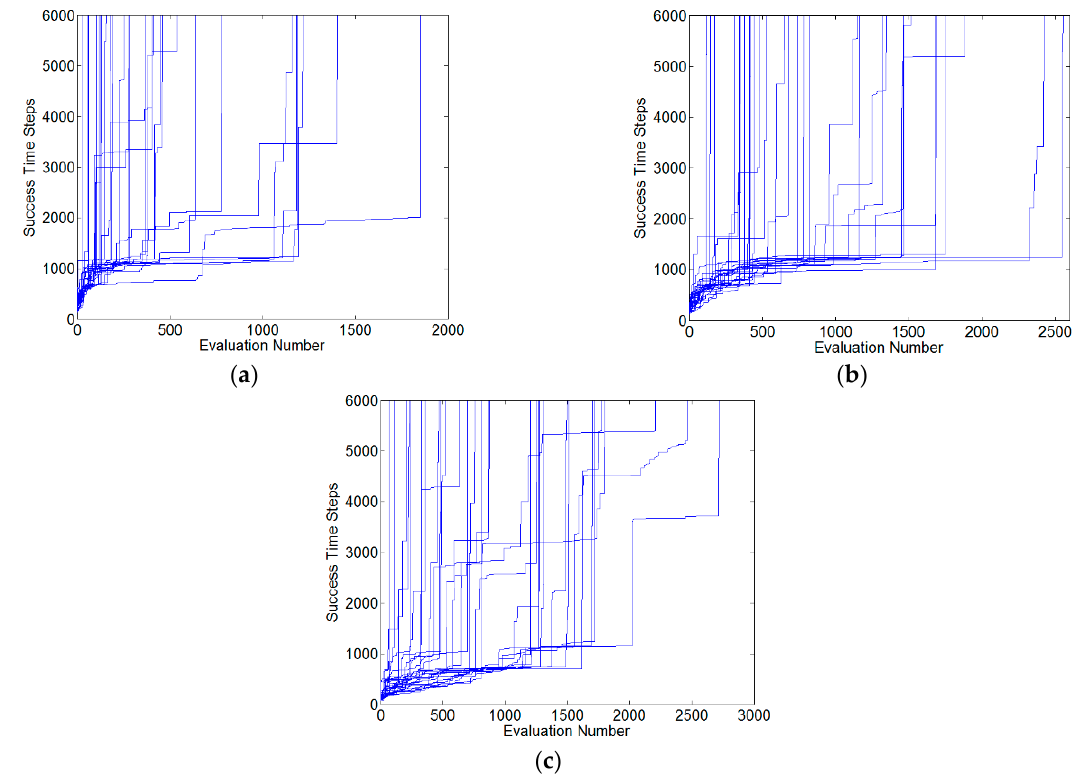
Figure 7. Mobile robot wall-following controller learning curve. ( a ) FLC_R-IDS method, ( b ) FLC_R-DS method and ( c ) FLC_R-CDS method.